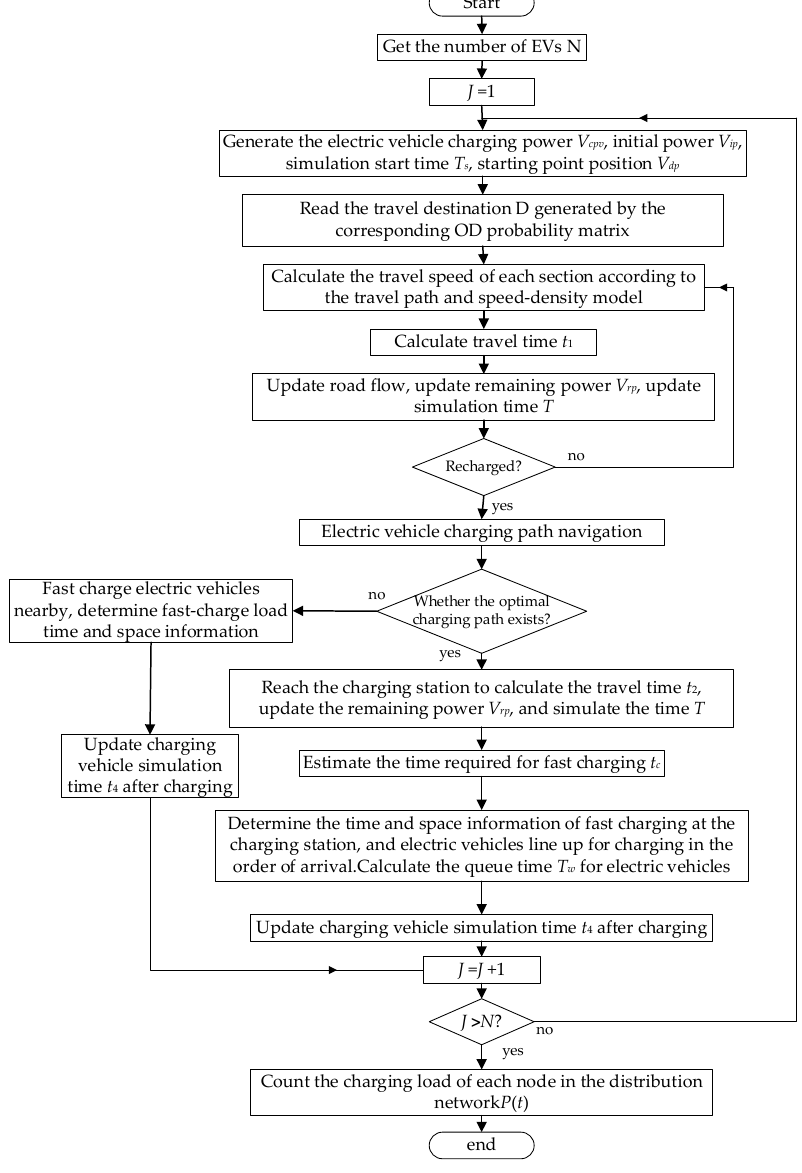
Figure 5. Flow chart of electric vehicle charging load space-time prediction.